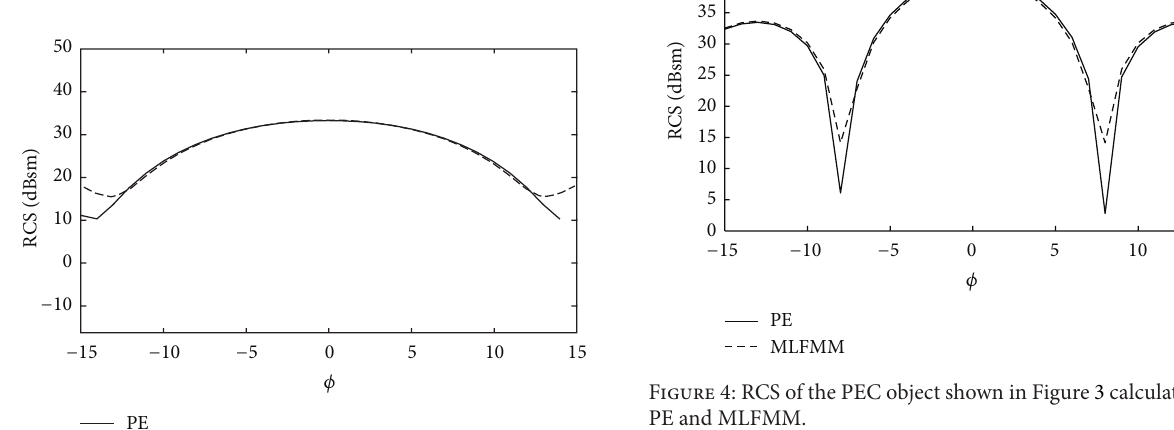
with thickness of 0.1 m, height of 20 m, and length of 20 m.